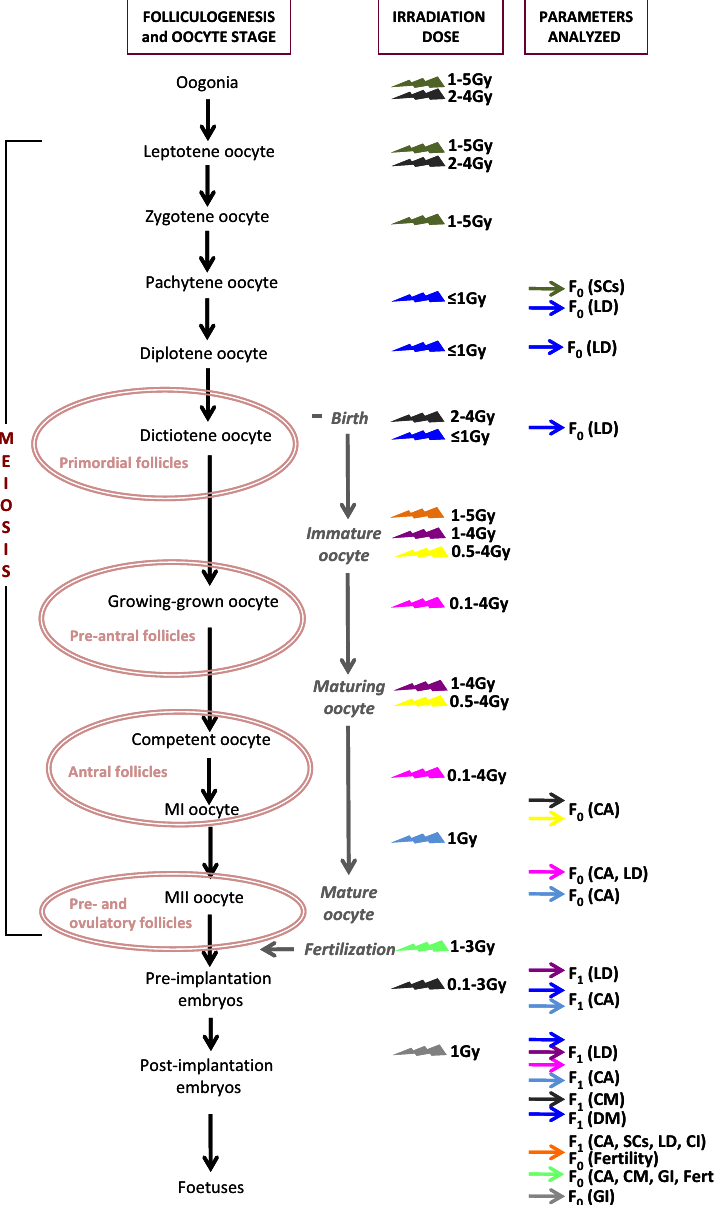
All phases of oogenesis are represented (from oogonia to ovulatory follicles) as well as earlier stages of embryo development (see text for details regarding female gametogenesis). The figure represents the moment of irradiation ( ) and the stage where the parameters were analyzed (arrows). Different colors indicate different studies reported: deep green (cid:62) 19 (cid:177) 21 (cid:64) , light green (cid:62) 22 (cid:177) 26 (cid:64) , black (cid:62) 27 (cid:177) 32 (cid:64) , deep blue (cid:62) 33 (cid:177) 36 (cid:64) , light blue (cid:62) 37,38 (cid:64) , orange (cid:62) 39 (cid:177) 43 (cid:64) , purple (cid:62) 44 (cid:64) , yellow (cid:62) 45,46 (cid:64) , indicates that the parameter has been pink (cid:62) 47 (cid:177) 50 (cid:64) , and grey (cid:62) 51 (cid:64) . For the parameters studied, F 0 analyzed in the irradiated female, whereas F indicates that the parameter has been analyzed in the 1 progeny of the irradiated female. Legend (cid:178) Gy: irradiation dose (Grey), CA: chromosomal aberrations, GI: genome instability, CM: congenital malformations, DM: developmental malformations, LD: lethal dose, SC: synaptonemal